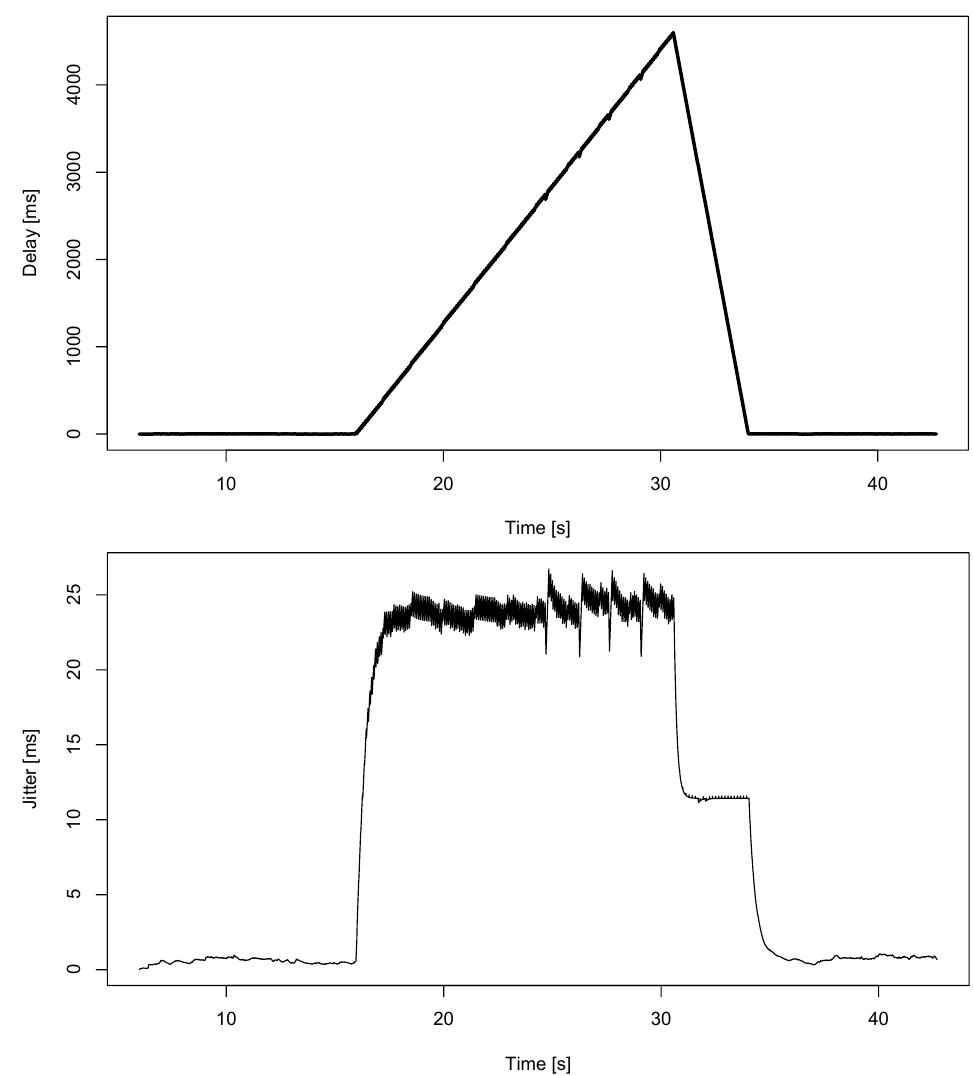
Figure 6. RTP delay jitter on the congested interface with the best-effort